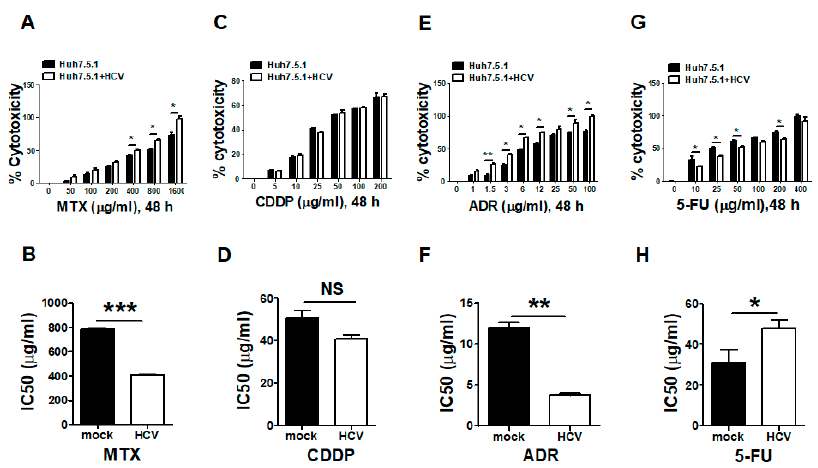
Figure 3. HCV infection caused 5-FU drug resistance. The effects of HCV infection on the chemosensitivity in Huh7.5.1 cells were evaluated using the lactate dehydrogenase (LDH) assay. The cytotoxicity and IC50 of MTX ( A , B ), CDDP ( C , D ), ADR ( E , F ) and 5-FU ( G , H ) in HCVcc-infected Huh7.5.1 cells was calculated using the LDH release assay.